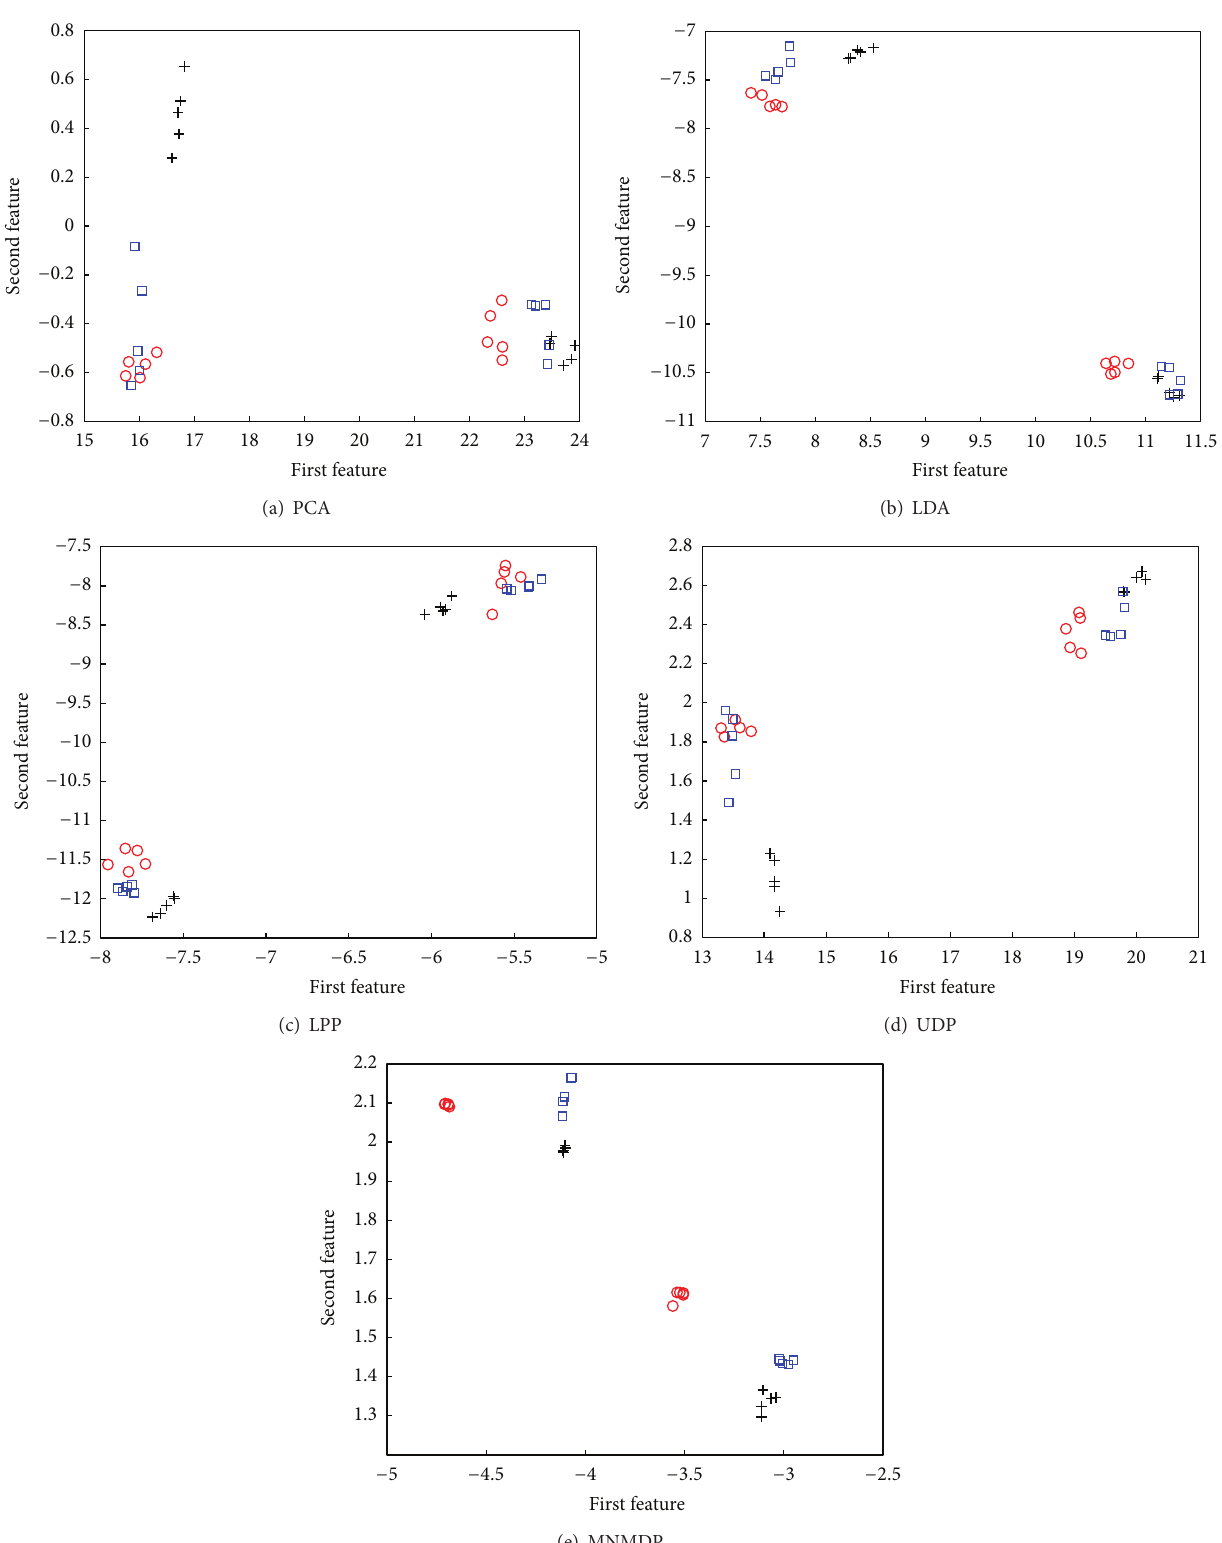
Figure 12: Data distribution of each method in two-dimensional projection space, where the three classes are denoted by “+”, “ l ”, and “ ◻ ”,